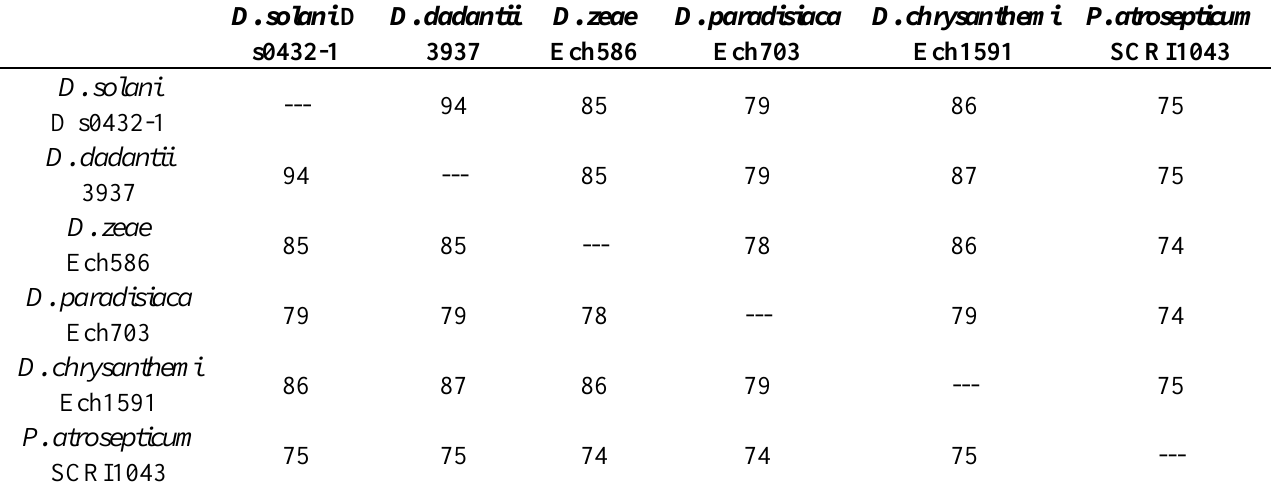
Table 1. Average Nucleotide Identity (ANI) calculated based on comparisons between D. solani D s0432-1 and other published Dickeya genomes. Pectobacterium atrosepticum SCRI1043 is included as a non- Dickeya pathogen for comparison.